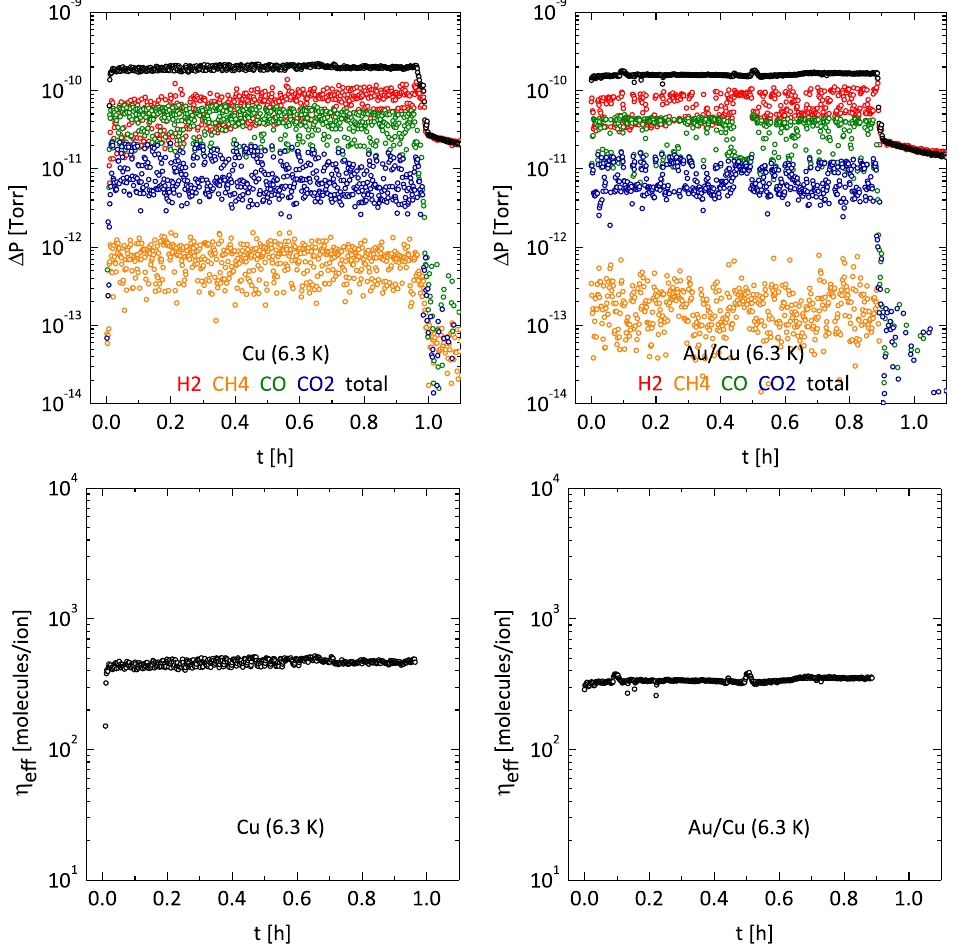
FIG. 4. Heavy-ion-induced gas desorption measurements at 6.3 K target temperature. Partial pressure rises ( (cid:2) P ) of H 2 , CH 4 , CO, CO 2 and total pressure measured for bare and gold-coated copper samples continuously bombarded under Pb 54 þ ions are shown together with the corresponding desorption yields ( (cid:2)